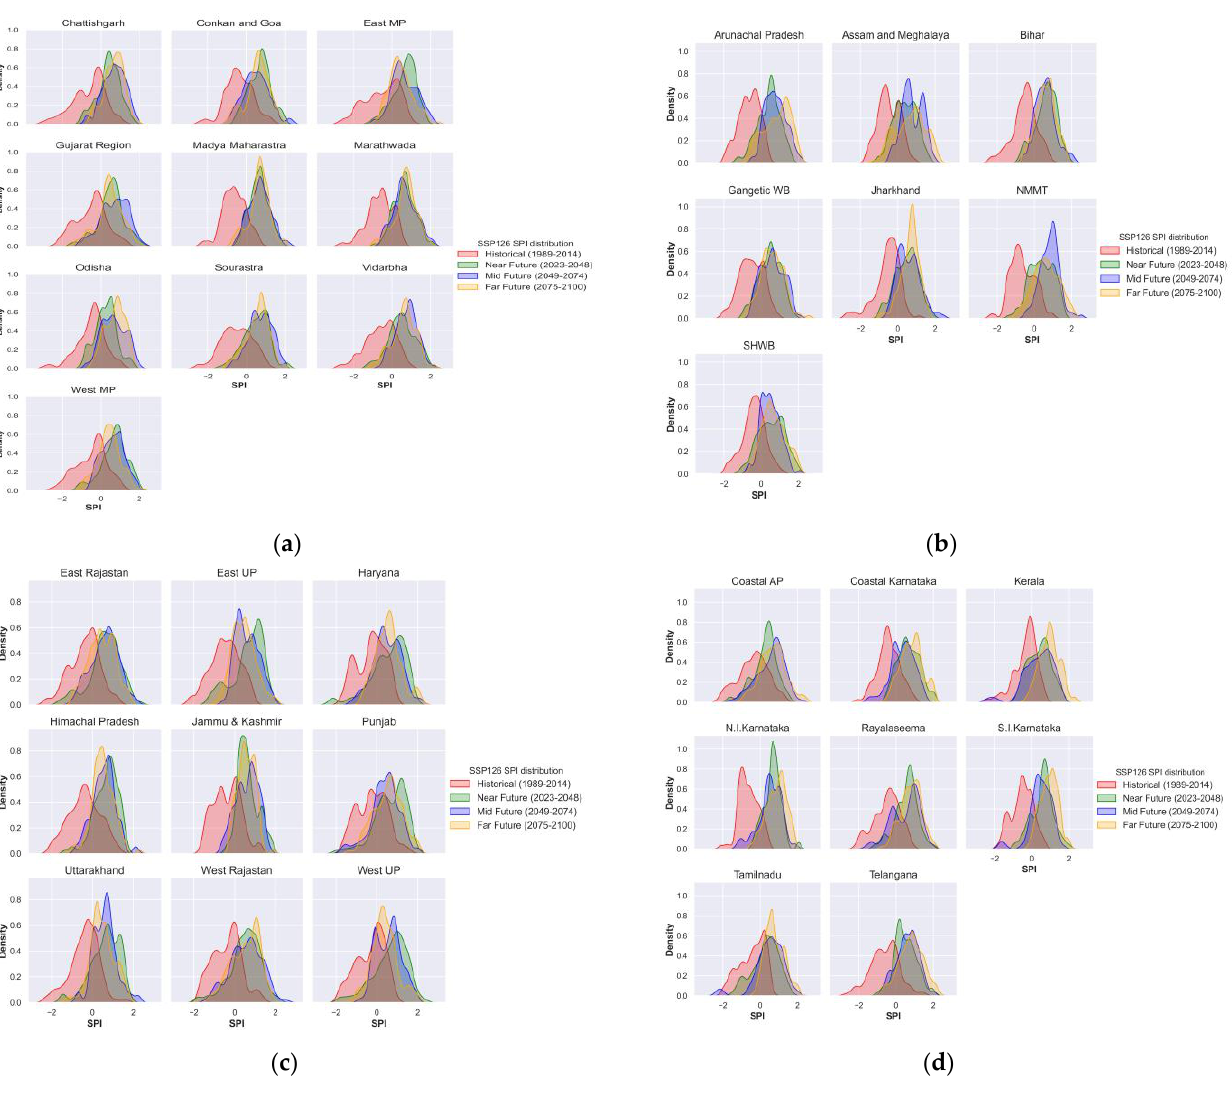
Figure 10. CMIP6 SSP126 scenarios 12-month Standard Precipitation Index (SPI) PDF plot at meteorological subdivision level ( a ) Central India, ( b ) East and Northeast India, ( c ) Northwest India, and ( d ) South Peninsula India for near, mid, and far future.